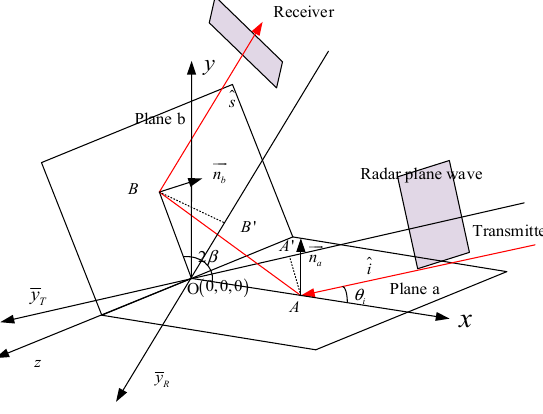
Figure 2. Propagation path of radar wave in the obtuse dihedral corner.